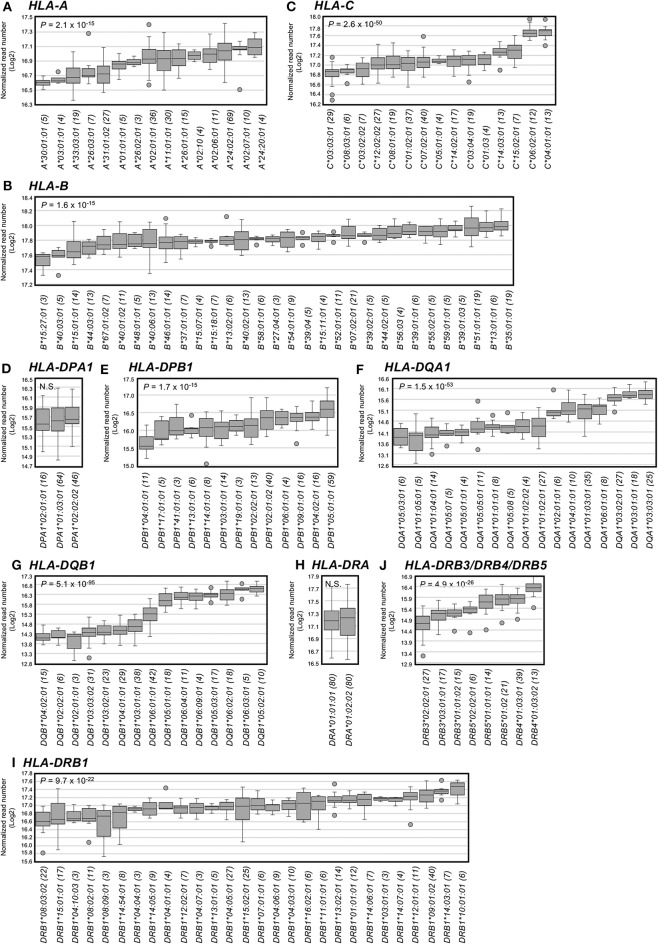
Allelic RNA levels expressed by 12 human leukocyte antigen (HLA) loci in peripheral blood mononuclear cell (PBMC) samples and measured by capture RNA-Seq. The box-and-whisker diagrams were drawn using the datasets 2–4 obtained from the sequence reads of 78 or 161 PBMC samples (Figure S1C). Panels (A–J) show (A)
HLA-A, (B)
HLA-B, (C)
HLA-C, (D)
HLA-DPA1, (E)
HLA-DPB1, (F)
HLA-DQA1, (G)
HLA-DQB1, (H)
HLA-DRA, (I)
HLA-DRB3/DRB4/DRB5, and (J)
HLA-DRB1. Vertical axis indicates normalized read numbers (log2) calculated as described in section Material and Methods. Horizontal axis indicates the alleles for each of HLA loci (A–J). Horizontal lines in the box indicate median expression at each allele. Parenthesis following the allele name indicates the number of individual points plotted per each locus.